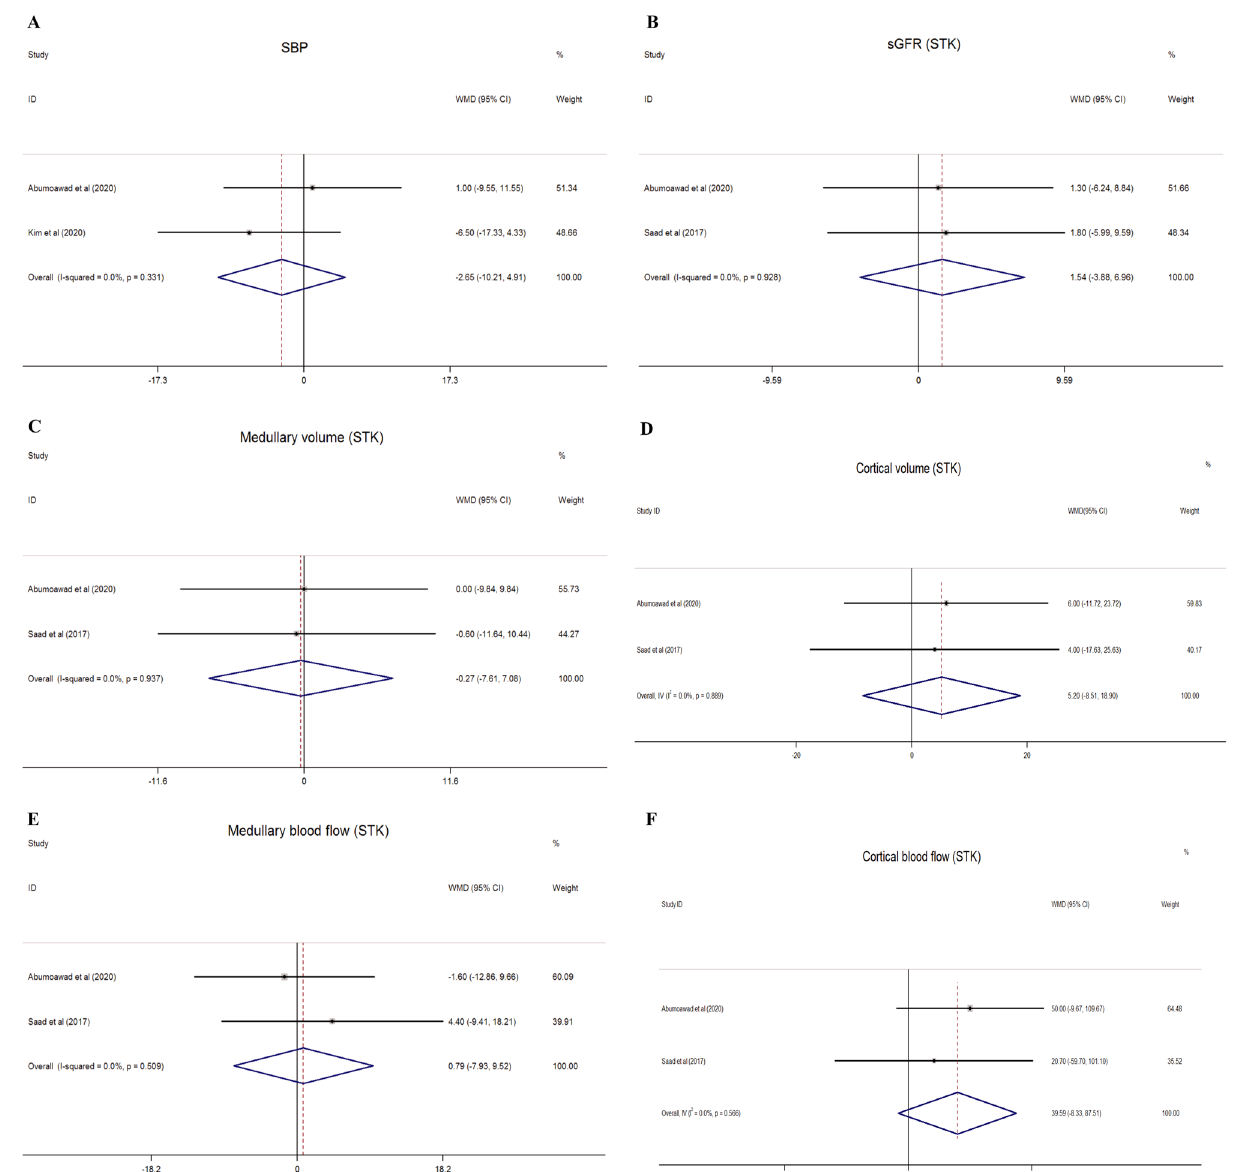
Figure 4. The effect of MSC therapy on systolic blood pressure ( A ), single-kidney glomerular filtration rate ( B ), medullary volume ( C ), cortical volume ( D ), medullary blood flow ( E ) and cortical blood flow ( F ) in stenotic kidney in clinical